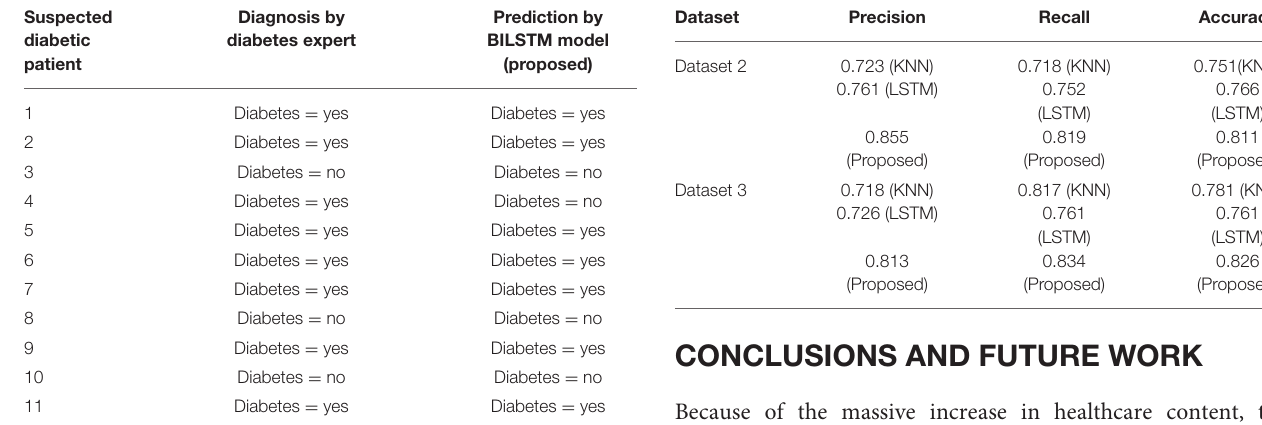
TABLE 8 | The human expert’s prognosis vs. the suggested system’s. Suspected diabetic